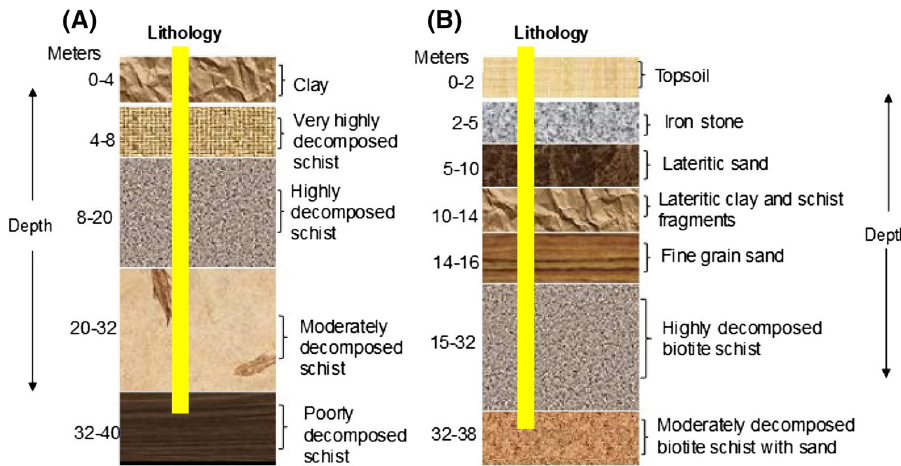
Fig. 4 Lithologic section of boreholes in the study area a Zuru and b